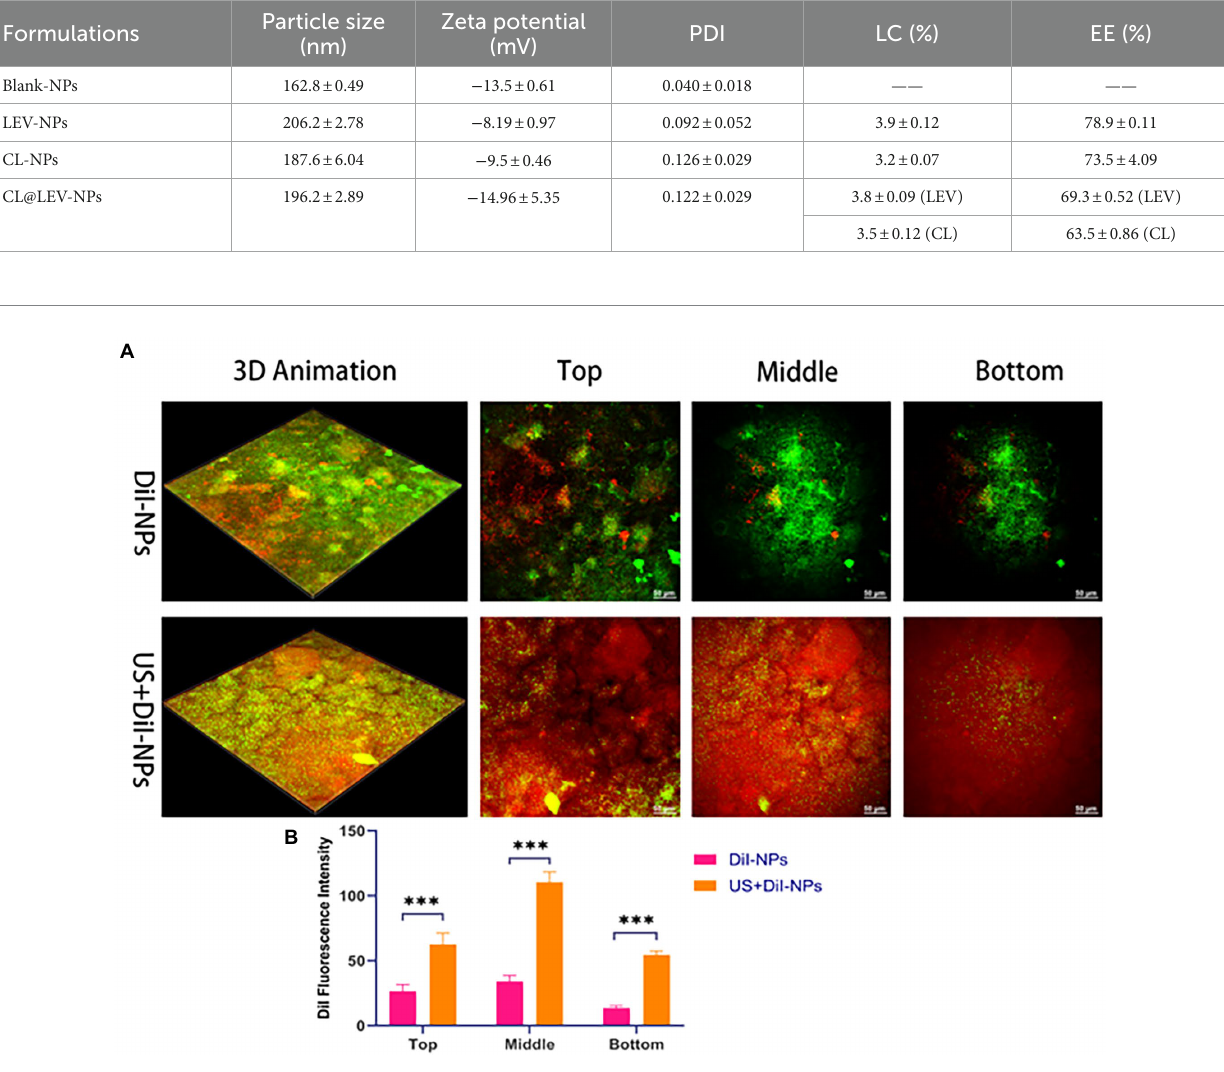
FIGURE 5 Biofilms permeability analysis following ultrasound treatment. (A) CLSM to observe the aggregation of nanoparticles between different layers in the biofilm with and without ultrasonic irradiation, respectively; green fluorescence: SYTO 9 labeled BCG biofilm; red fluorescence: DiI labeled nanoparticles, scale bar 50 μ m (200×); (B) Quantitative analysis of DiI fluorescence intensity in the top, middle and bottom layer of biofilm after ultrasonic irradiation. *** p <